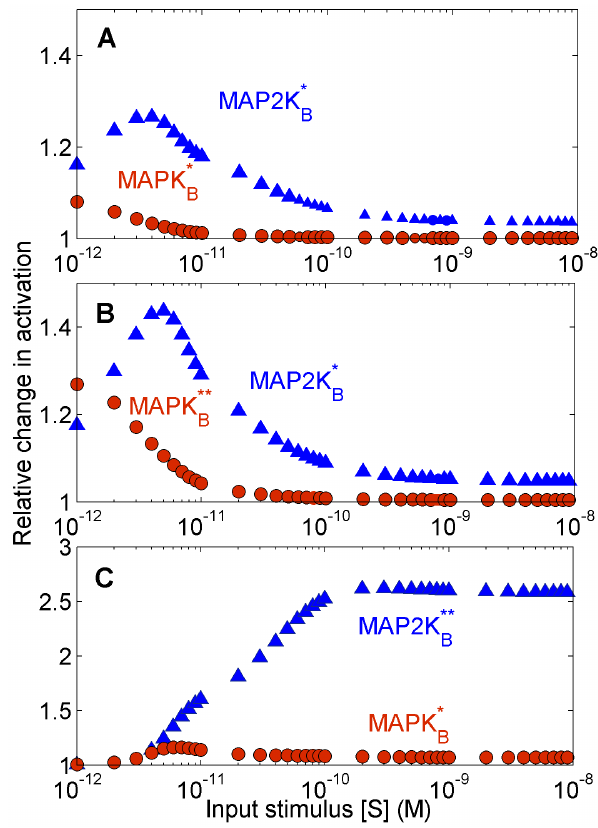
Figure 7. Role of competitive inhibition. Relative increase with stimulus strength of the steady-state response of different molecular species in the unperturbed branch B (MAP2K B and MAPK B ) shown as a function of signal concentration, when phosphorylation of MAPK A is prevented. In (A) both MAP2K and MAPK are singly phosphorylated, while in (B) MAP2K are singly phosphorylated but MAPK are doubly phosphorylated. Note that there is a small increase in the steady-state response of MAP2K B and MAPK B in (B) compared to (A). (C) When MAP2K are doubly phosphorylated whereas MAPK are singly phosphor- ylated, the relative increase in steady-state activity of MAP2K B and MAPK B is more prominent.